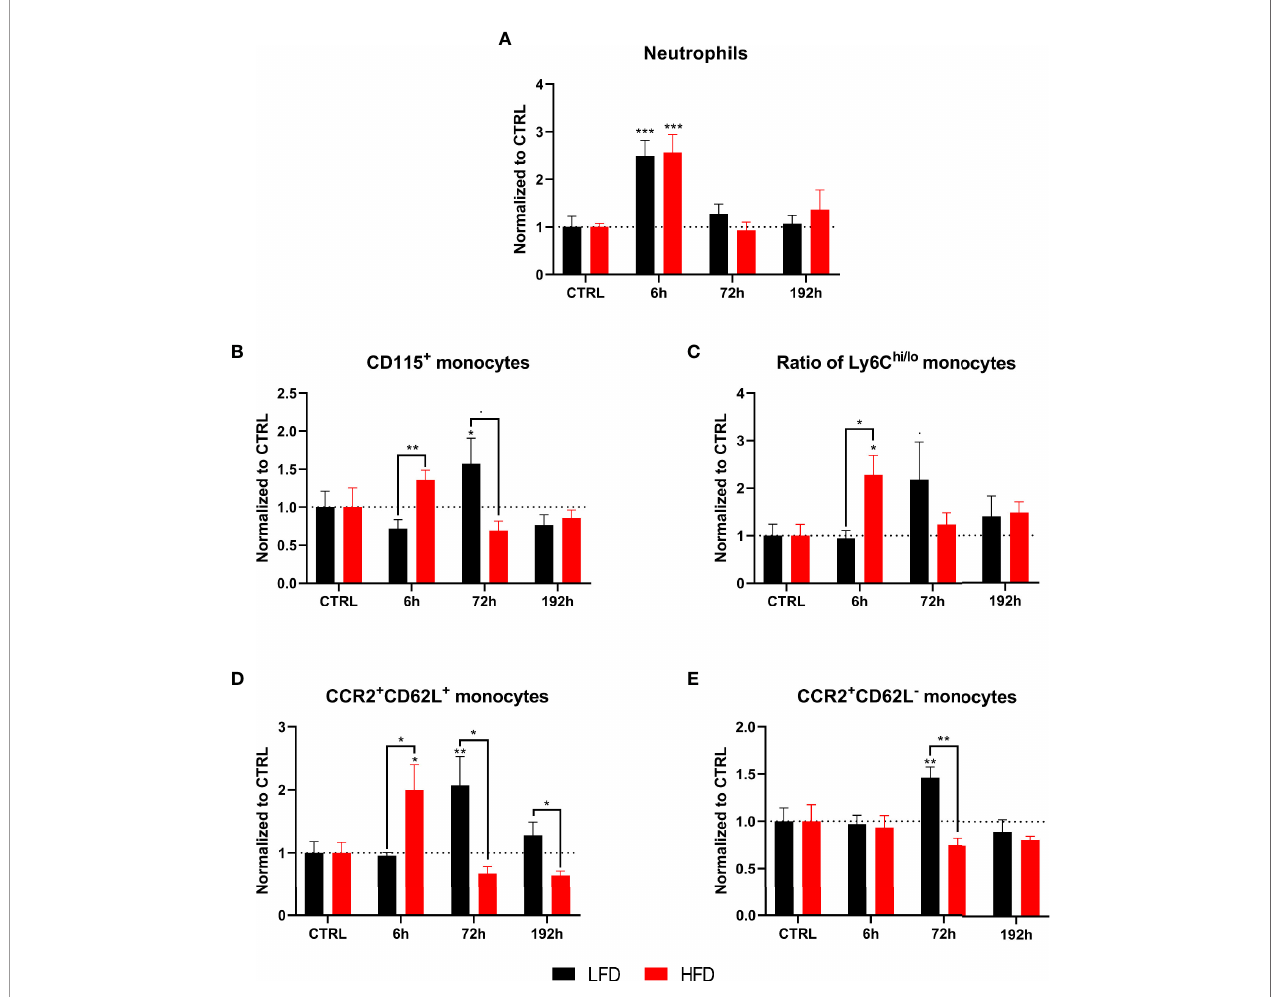
FIGURE 6 | CyTOF analysis of immune population in the lung of lean and obese mice after trauma. Baseline-corrected (ratio) timelapse for neutrophils (A) , monocytes (B) , the ratio of Ly6C hi/lo monocytes (C) , as well as CCR2 + CD62L + monocytes (D) , and CCR2 + CD62L - monocytes (E) . Statistics: two-way ANOVA with an uncorrected Fisher ’ s LSD test as follow-up was used to compare the level to the respective CTRL, signi fi cance indicators are displayed directly above the bar; unpaired two-tailed Student ’ s t -test was used for comparison of lean and obese mice at a speci fi c time point, signi fi cance indicators are displayed next to the connector line. ▪ indicates p ≤ 0.1, * indicates p ≤ 0.05, ** indicates p ≤ 0.01, *** indicates p ≤ 0.001. Sample sizes: LFD CTRL = 5, LFD 6 h = 5, LFD 72 h = 6, LFD 192 h = 5, HFD CTRL = 5, HFD 6 h = 5, HFD 72 h = 4, HFD 192 h = 5. Data are displayed as mean ±